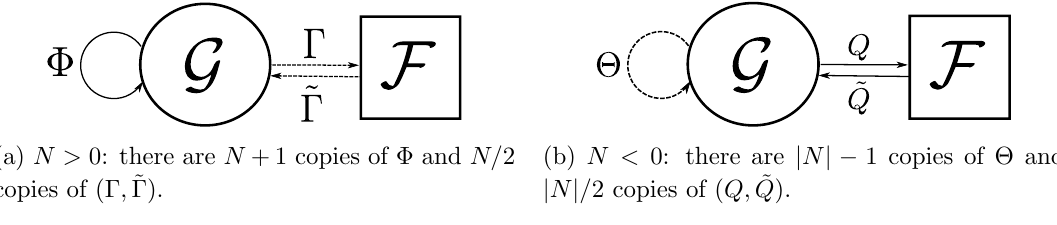
Figure 1. Schematic matter content of the 2d gauge theory obtained by twisted reduction on S 2 . G denotes the gauge group and F denotes the (cid:13)avor